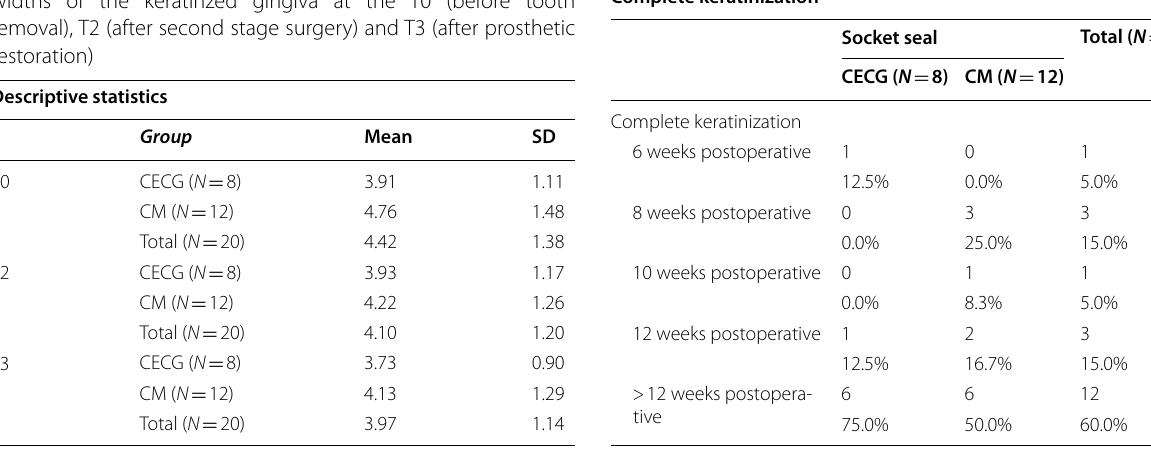
(Table 3). Emergence profile Measurement of the emergence profile was carried